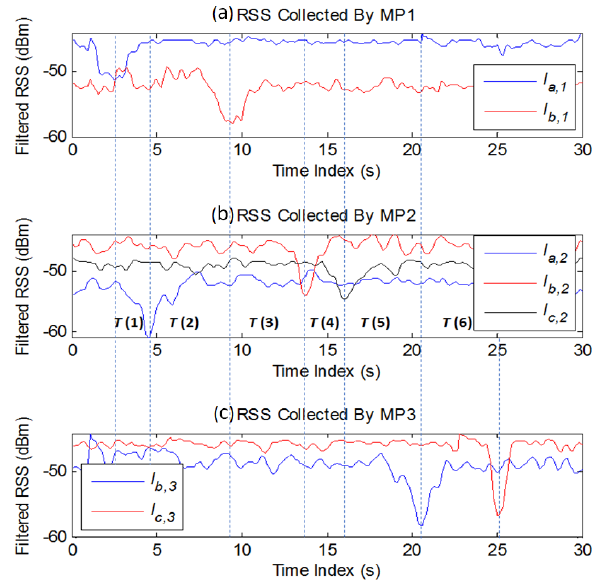
Figure 9. The measured RSS after filtering when three AP-MP pairs are distributed across the monitoring area (MP interval = 6 m).